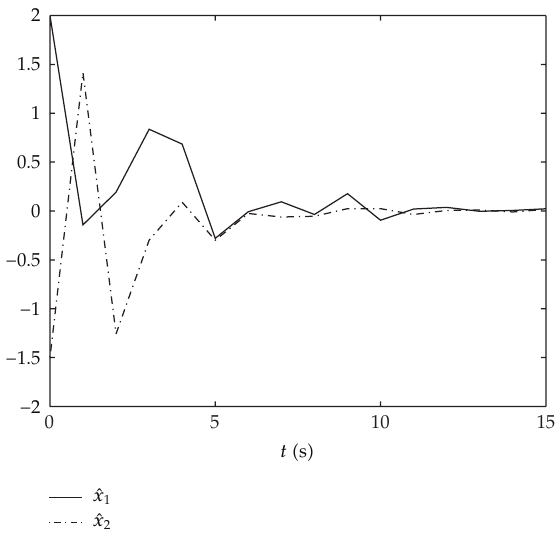
Figure 2: The estimation of filter (cid:2) x (cid:3) k (cid:4) .